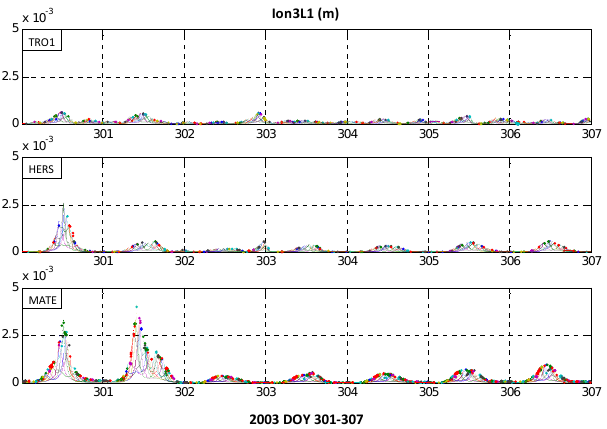
Fig. 9. Ion2 (m) for GPS L1 (Ion2L1) for the observation stations on DOY 301‐307 in 2003.